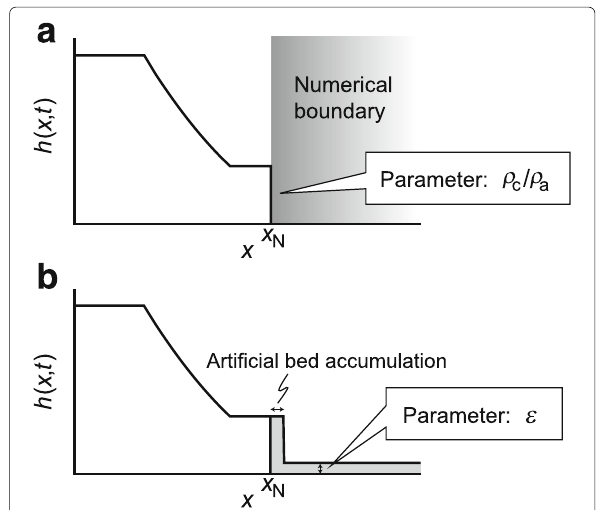
Fig. 3 Schematics of the numerical models used to calculate the front condition. a Boundary Condition (BC) model. b Artificial Bed (AB)